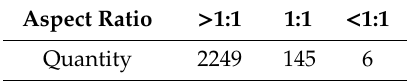
Table 1. Statistics of the ratio of target minimum circumscribed rectangle length to